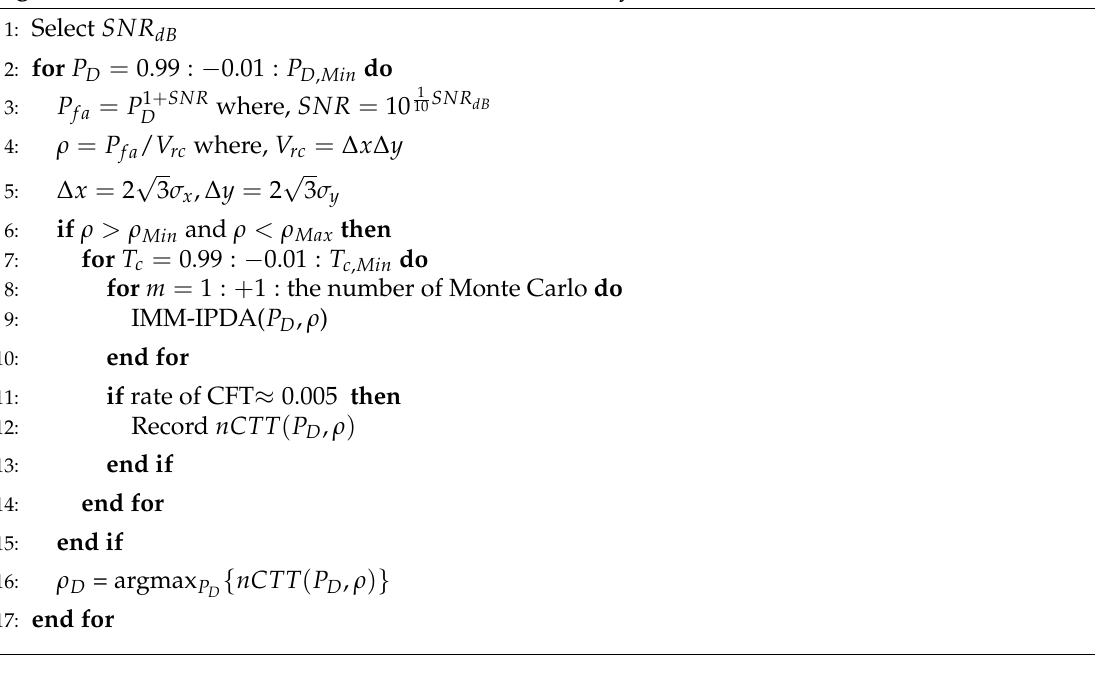
Algorithm 1 Find the desired clutter measurement density.